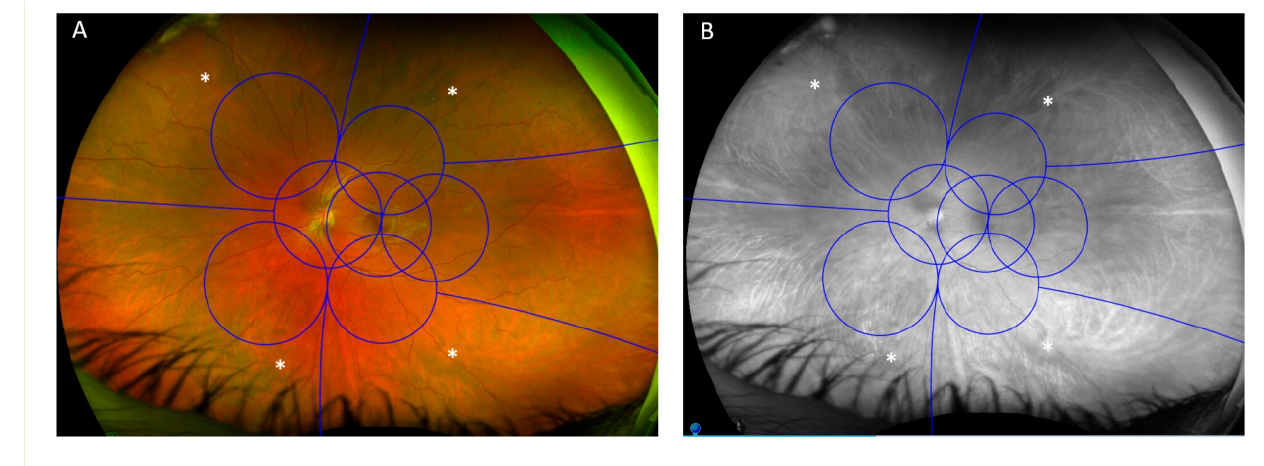
Figure 1. Early treatment diabetic retinopathy study (ETDRS) seven-standard fields compared to ultrawide fields (UWF). ( A ) Color UWF image showing an overlay of the seven scheme fields. ( B ) A green-filtered image of the same eye showing enhanced visibility of the choroidal vessels and locations of the vortex veins (white asterisk).